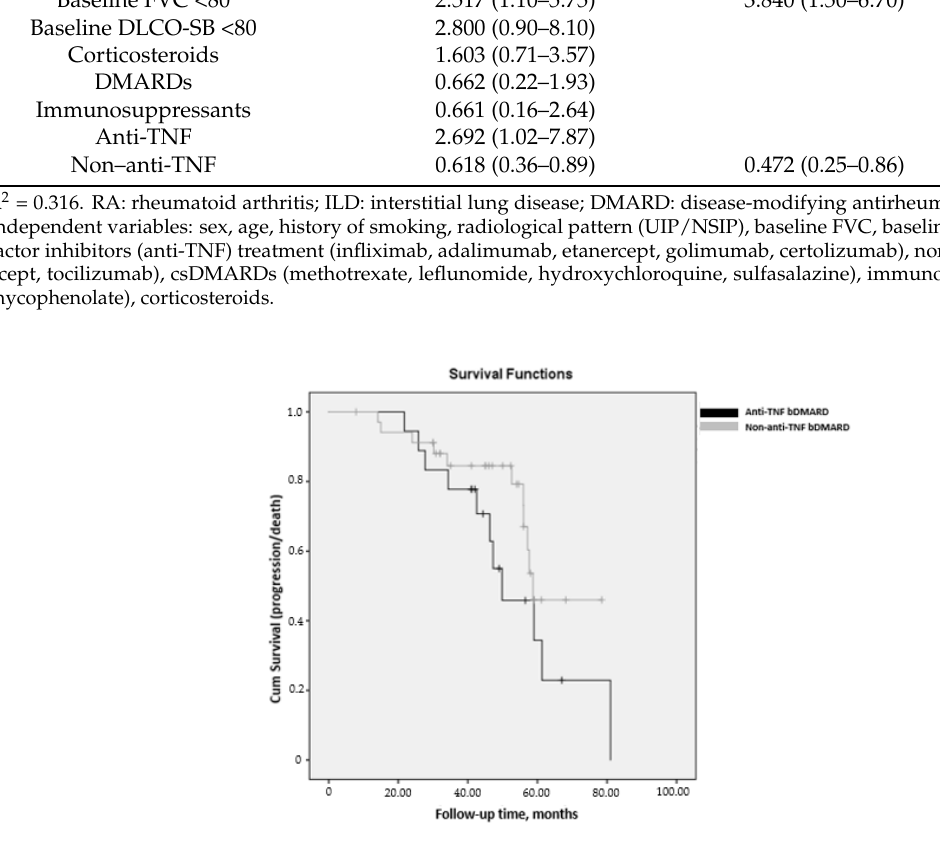
Figure 4. Kaplan–Meier survival curves measured from v0 until the end of follow-up (v60) or pro- gression/death, stratified by bDMARD in 116 patients at risk with RA-ILD. Survival was greater for patients taking non–anti-TNF bDMARDs than for those taking anti-TNF bDMARDs (mean